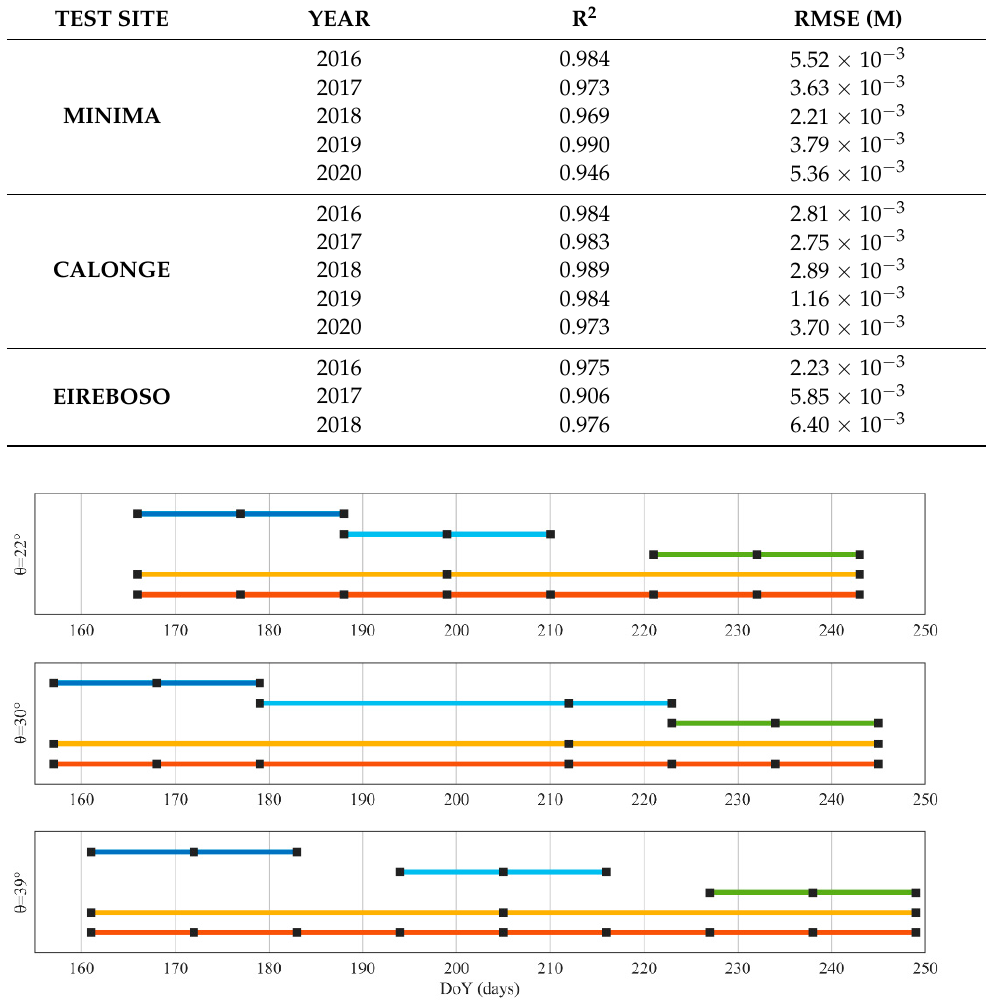
Table 3. Regression results in the test sites with ground-truth data from 2016 to 2020.